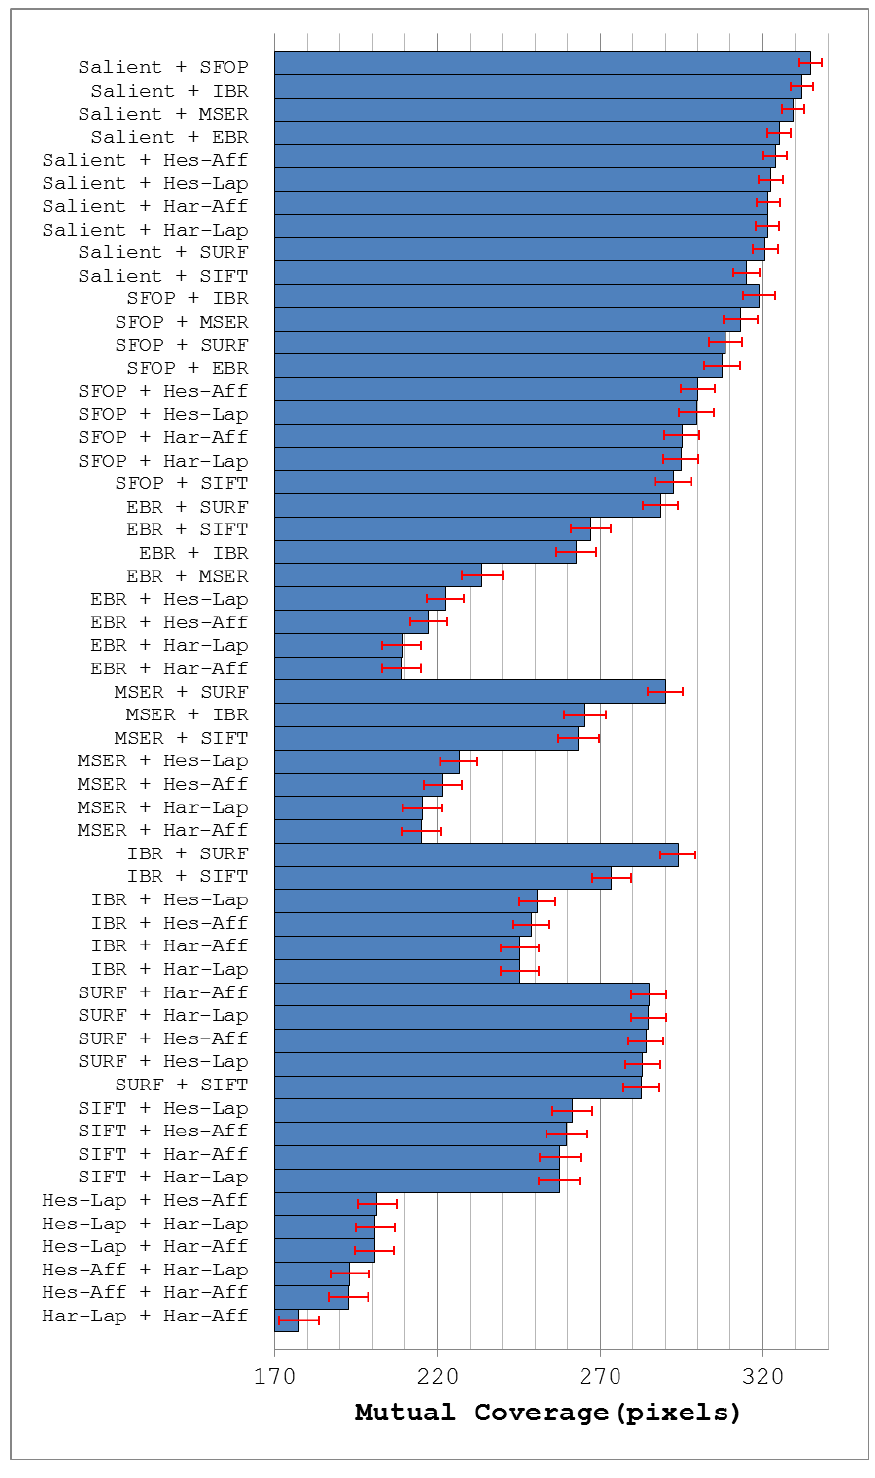
Figure 9. Mutual coverage of different feature detector pairs for image database [24]; the error bars indicate the 95% confidence intervals for mean